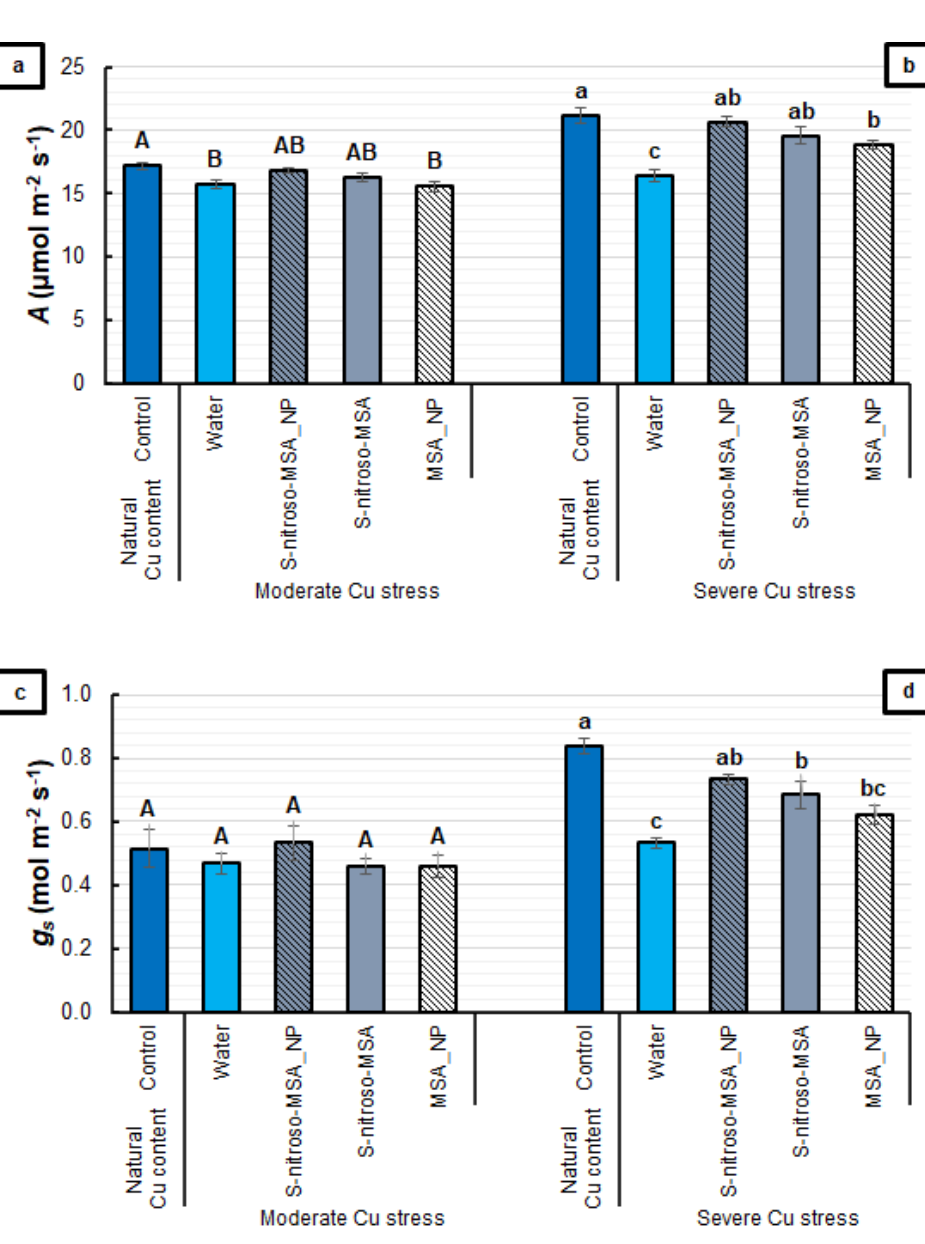
Figure 4. Net photosynthetic rate ( A ) ( a , b ) and stomatal conductance ( g s ) ( c , d ) of soybean plants cultivated in soil containing different copper (Cu) levels (natural content: 11 mg kg − 1 ; moderate Cu stress: 164 mg kg − 1 ; severe Cu stress: 244 mg kg − 1 ). Control = treatment with distilled water; water = treatment with distilled water after the Cu addition; S-nitroso-MSA_NP = treatment with a nanoencapsulated NO donor (S-nitroso-mercaptosuccinic acid) at 1 mM; S-nitroso-MSA = treatment with a NO donor (S-nitroso-mercaptosuccinic acid) in the free form at 1 mM; MSA_NP = treatment with nanoparticles containing the non-nitrosated MSA at 1 mM. Data are the mean ± standard error ( n = 8). The same uppercase and lowercase letters on the column (referring to experiments 1 and 2, respectively) indicate values that do not differ by ANOVA, followed by the Tukey test ( p < 0.05).